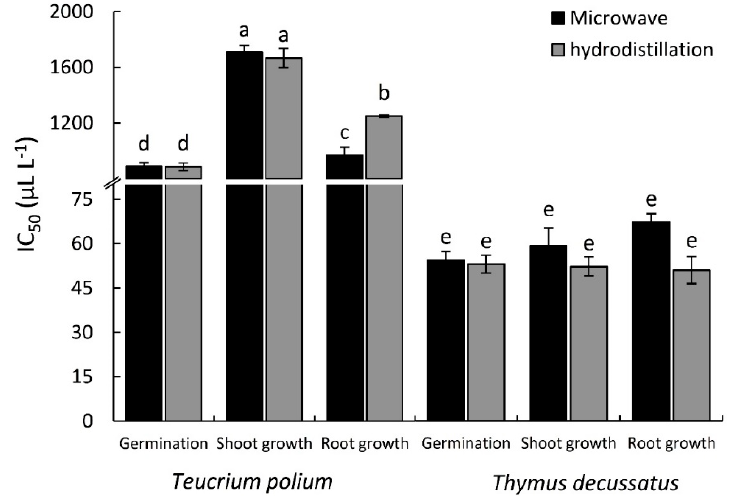
Figure 2. The IC 50 values of the essential oils extracted from Teucrium polium and Thymus decussatus using the microwave-assisted extraction (MAE) and hydrodistillation (HD) methods, based on the inhibition of the seed germination and seedling growth of lettuce. Di ff erent letters of columns mean values are significantly di ff erent at p ≤